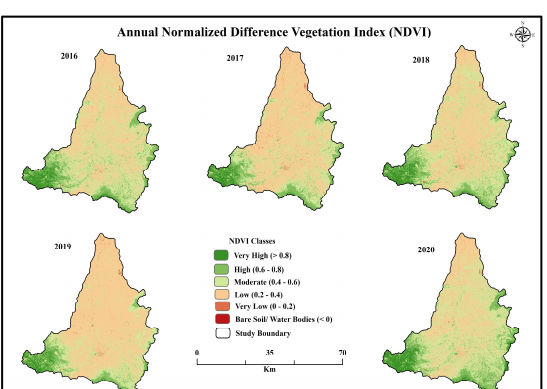
Figure 5: Annual Normalized Difference Vegetation Index of 2016 to 2020